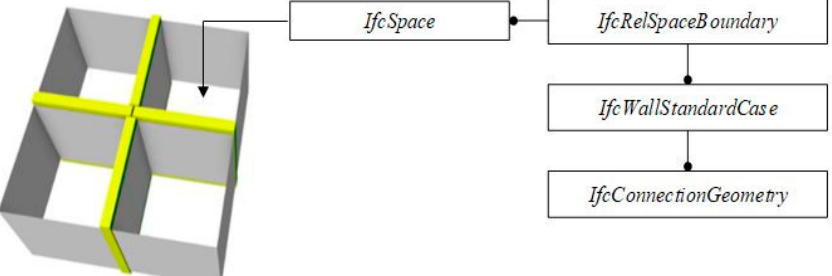
Figure 1. Valid IFC definition of the wall for each space.